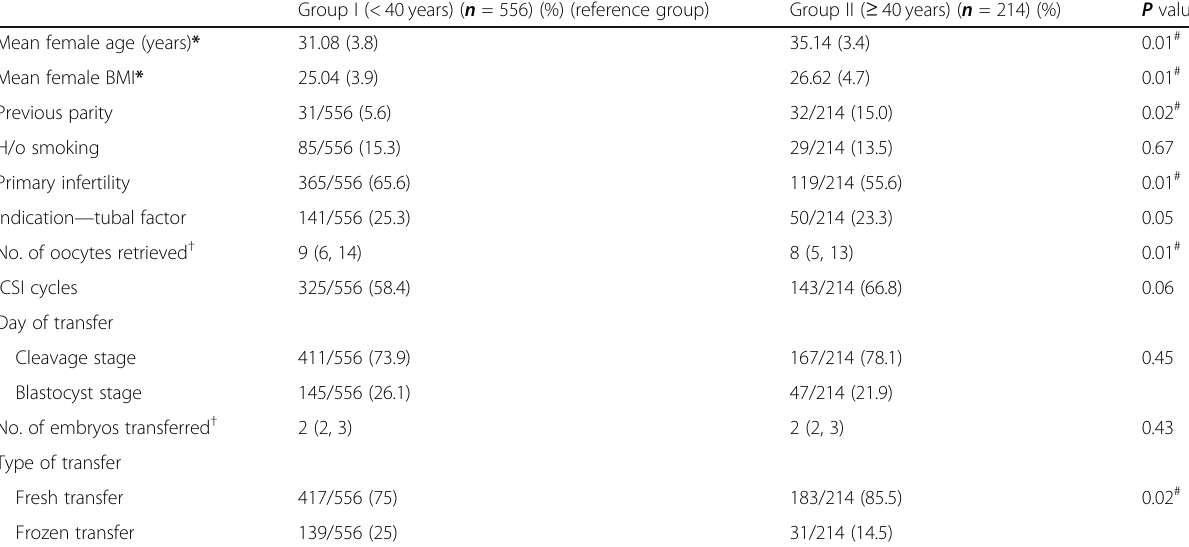
Table 1 Baseline characteristics of group I (male partner age < 40 years) and group II (male partner ≥ years)